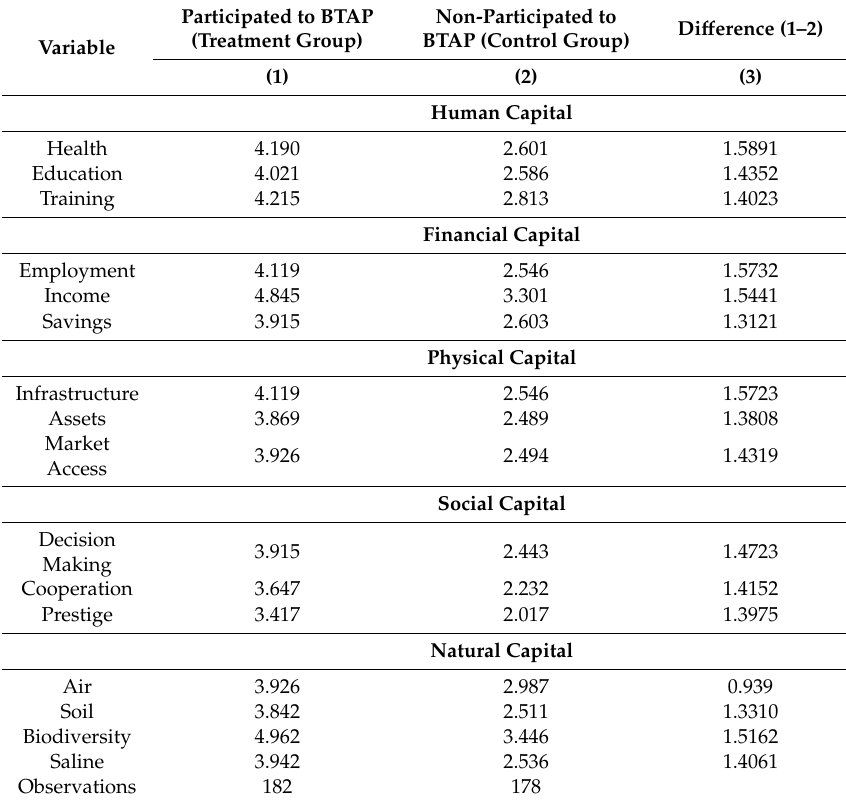
Table 2. Descriptive statistics of treatment and control group